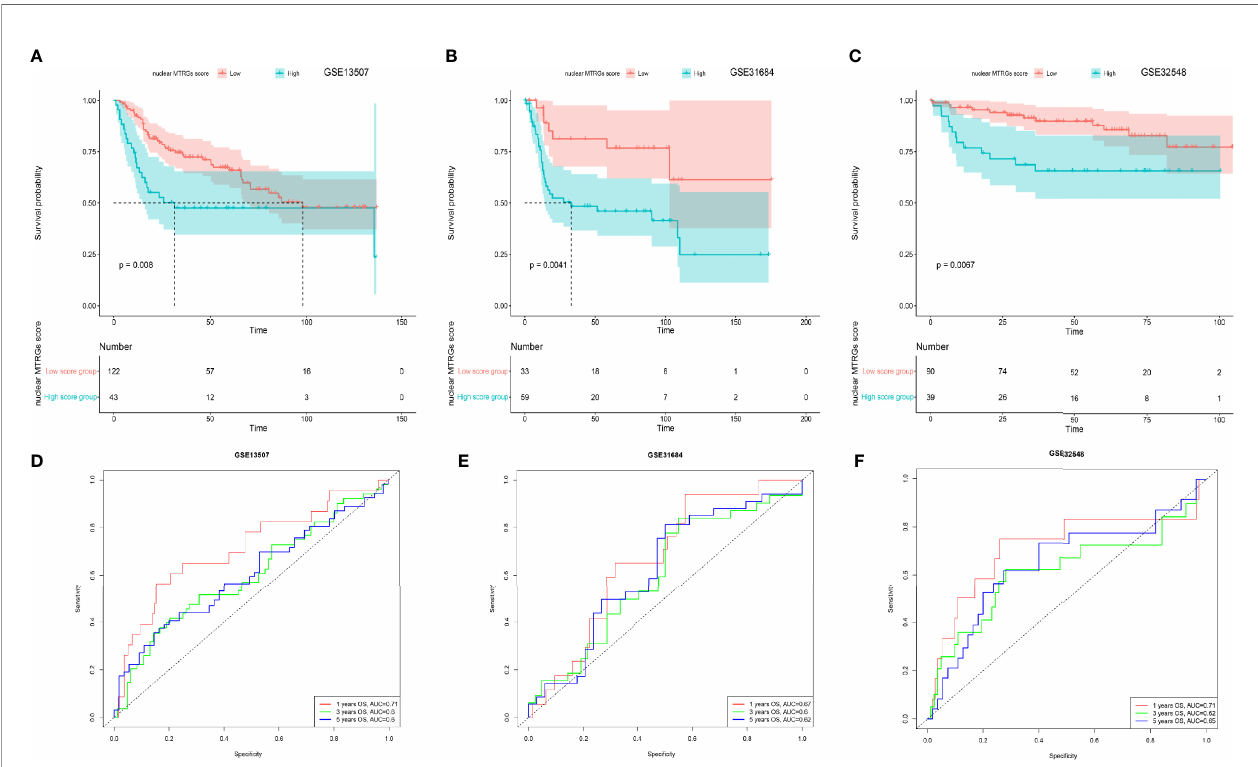
FIGURE 3 | The comparison of the OS and AUC values between the high and low nuclear MTRGs score groups. The analysis of Kaplan-Meier curves for BC patients assigned to high and low nuclear MTRGs score groups in GSE13507 (A) , GSE31684 (B) , and GSE32548 (C) . The corresponding ROC curves for OS at 1,